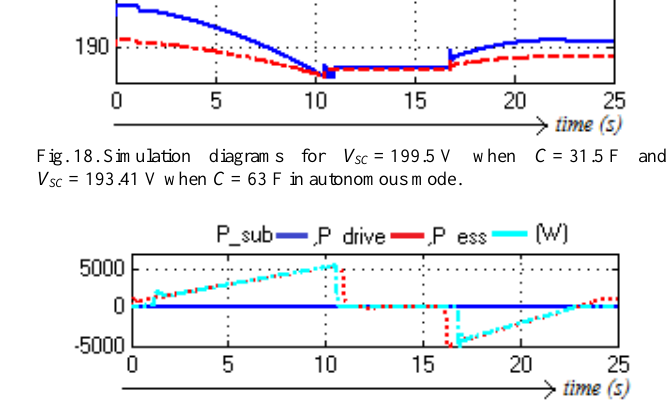
Fig. 19. Simulation diagram of power for both C = 31.5 F and C = 63 F in autonomous mode.